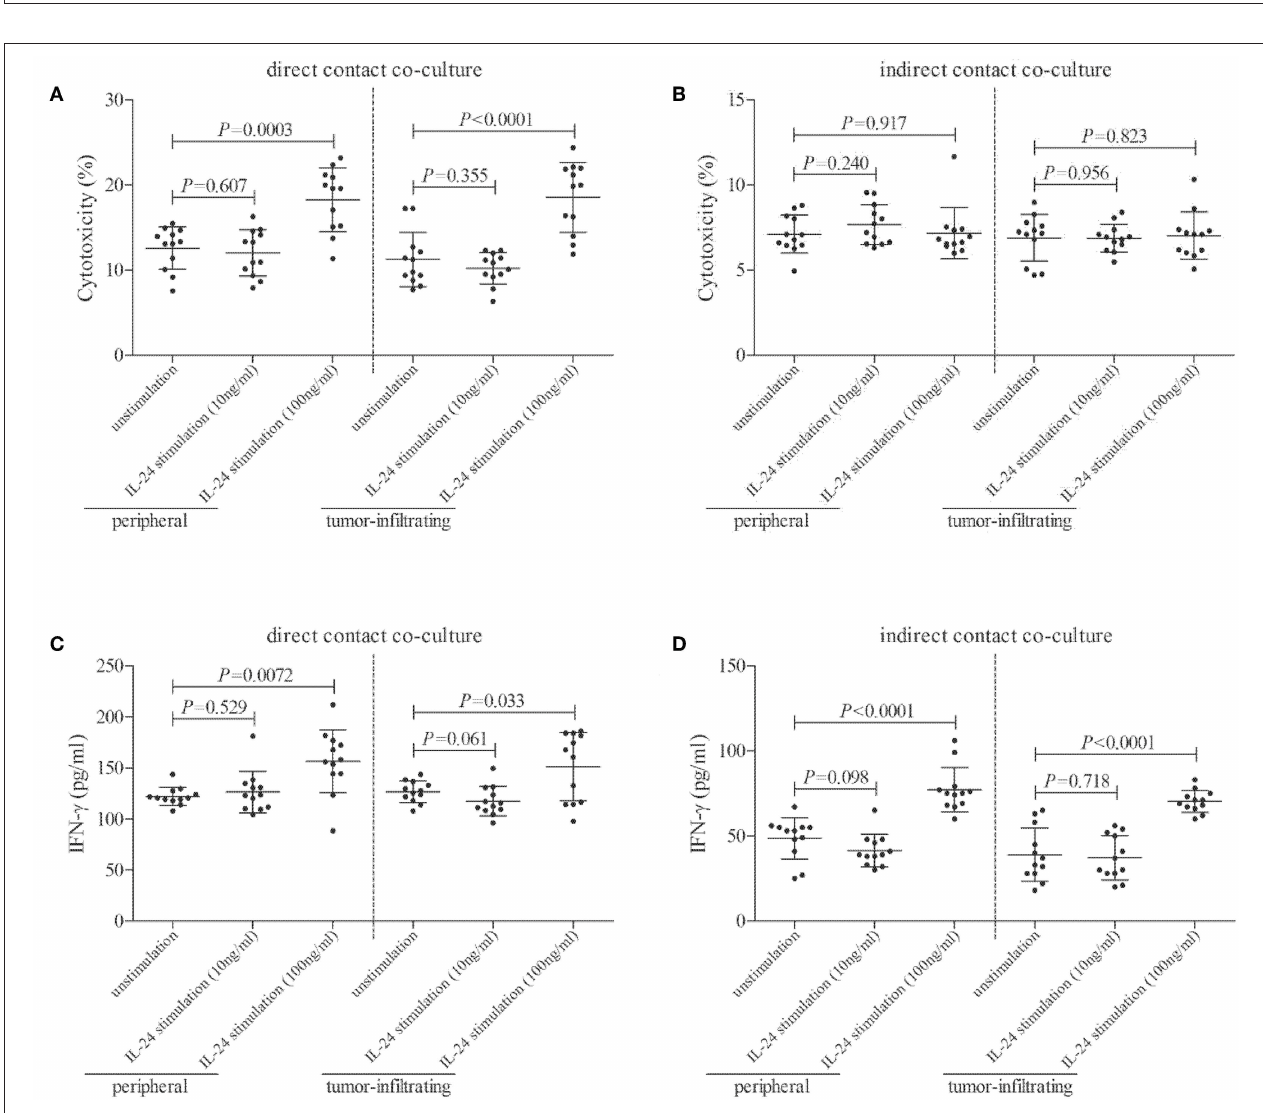
FIGURE 6 | Influence of recombinant IL-24 stimulation on cytolytic and non-cytolytic function of CD8 + T cells in colorectal adenocarcinoma. CD8 + T cells were purified from HLA-A2 restricted colorectal adenocarcinoma patients ( n = 12), and were stimulated low concentration (10ng/ml) or high concentration (100ng/ml) of recombinant human IL-24 for 24h. 5 × 10 4 of IL-24 stimulated CD8 + T cells were co-cultured in direct contact and in parallel in indirect contact system with 2.5 × 10 5 of colorectal adenocarcinoma cell line CACO-2 for 48h. Cytotoxicity of target CACO-2 cells was calculated by measurement of LDH expression in the cultured supernatants. IFN- γ and TNF- α expression in the cultured supernatants was measured by ELISA. (A) Cytotoxicity of target CACO-2 cells in direct contact co-culture system (One-way ANOVA, P < 0.01). (B) Cytotoxicity of target CACO-2 cells in indirect contact co-culture system (One-way ANOVA, P > 0.05). (C) IFN- γ expression in direct contact co-culture system (One-way ANOVA, P < 0.001). (D) IFN- γ expression in indirect contact co-culture system (One-way ANOVA, P < 0.0001). Individual level of each subject was shown. One-way ANOVA and Tukey test for multiple comparison was used for comparison.